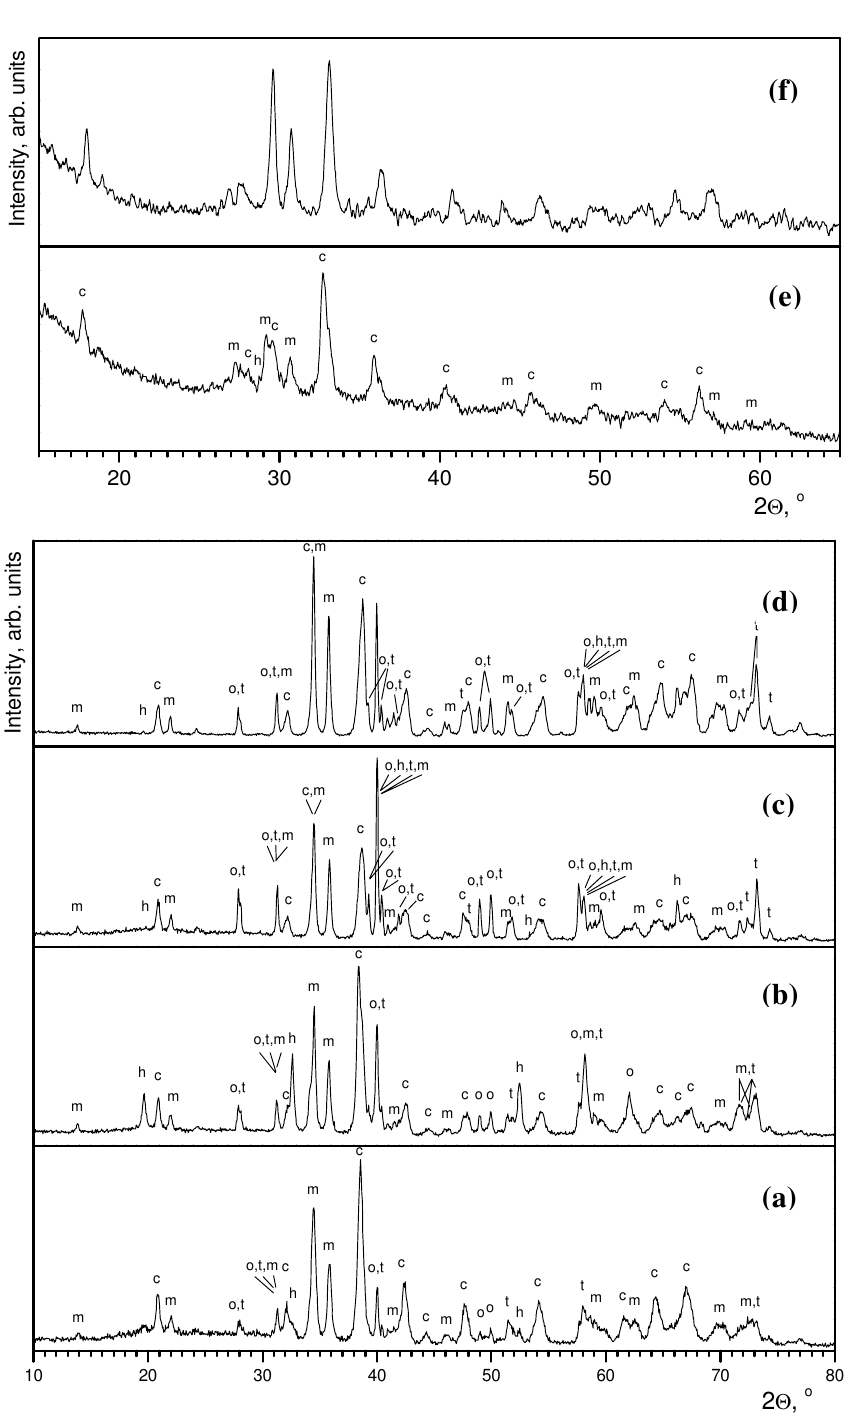
Fig. 6 X - ray diffractograms (CoK : a - d, CuK : e, f) of products obtained after α α heating of: YAlCit for 1 h at 450 ◦ C and 2.5 h at 1000 ◦ C (a) or 1150 ◦ C (c) or 850 ◦ C (e); polyester resin, heated for 6 h at 300 ◦ C and for 4 h at 1000 ◦ C (b) or 1150 ◦ C (d) or 850 ◦ C (f); c - cubic YAlO , o - orthorhombic YAlO , h – hexagonal YAlO 3 3 Y Al O , t - tetragonal Y Al O 4 2 9 3 5 12